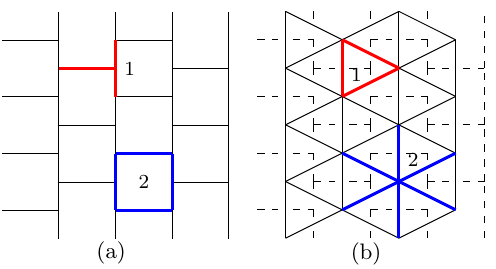
Figure 3 . A closed trivalent graph (cid:0) (a) and its dual graph (cid:0) (cid:3) (b). A vertex v (a plaquette p ) of (cid:0) becomes a plaquette p (cid:3) (a vertex v (cid:3) ) of (cid:0) (cid:3)